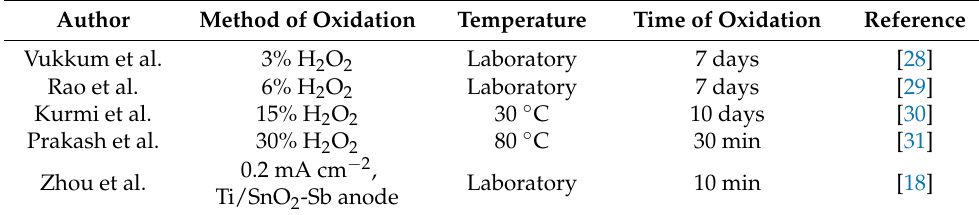
Table 1. Overview of published methods on abacavir